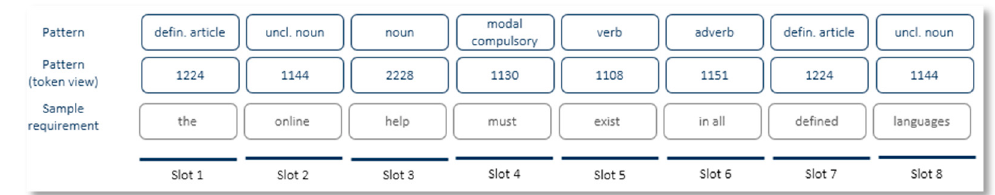
Figure 1. Example of requirement pattern within the RAT tool. Tokens are integers representing syntactical and semantic terms.